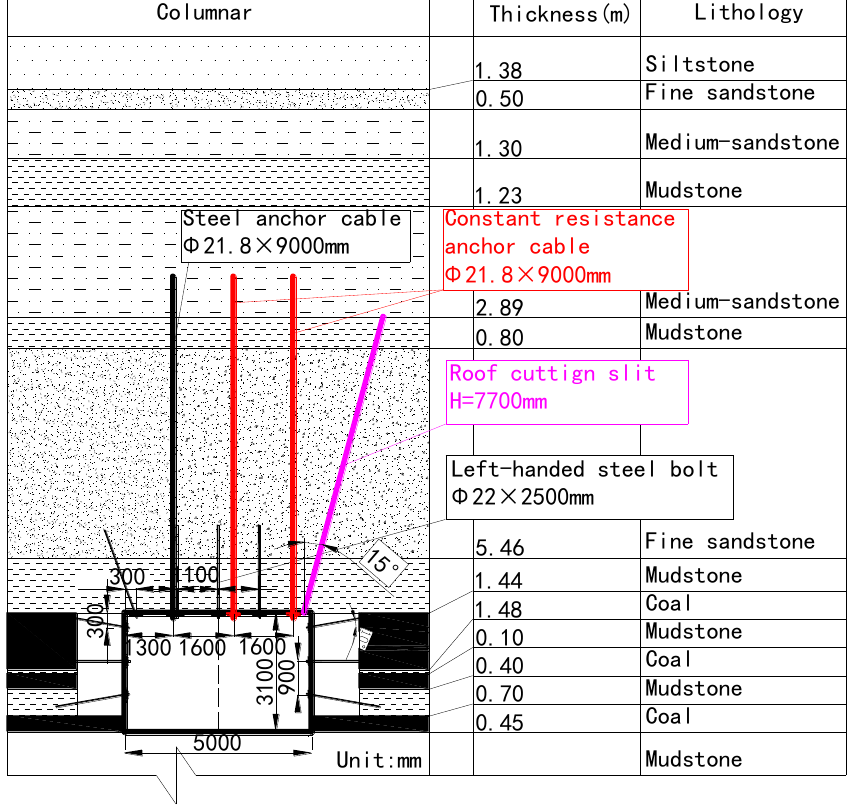
Figure 3 . Roof cutting and supporting design of the 8304 longwall working face tail gateway. Figure 3. Roof cutting and supporting design of the 8304 longwall working face tail